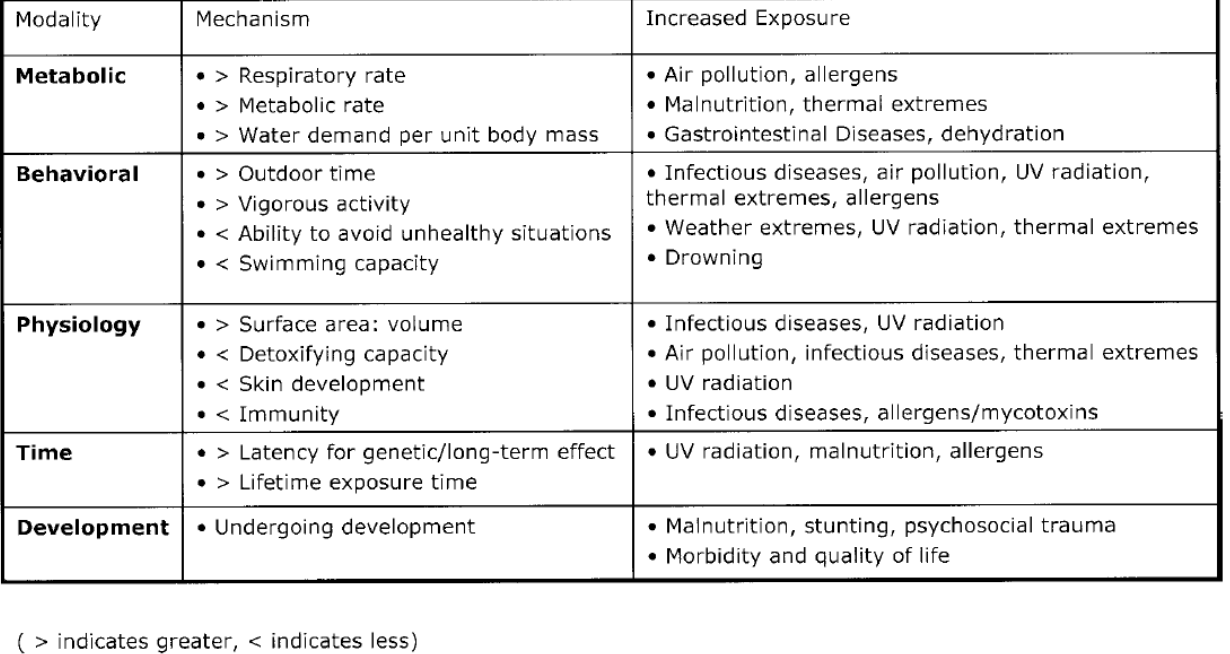
Figure 4. Modalities and mechanisms by which children may be more susceptible to climate change than adults